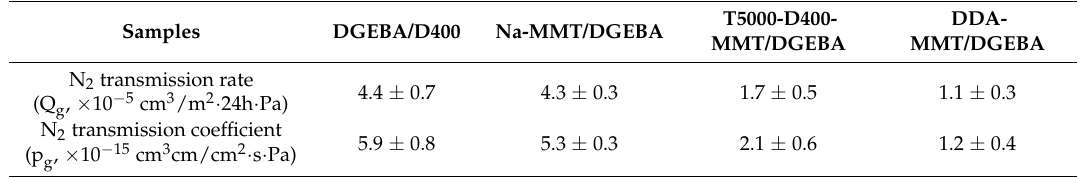
Table 6. N 2 transmission rate and coefficient of neat DGEBA/D400 epoxy resin and MMT/DGEBA nanocomposites.